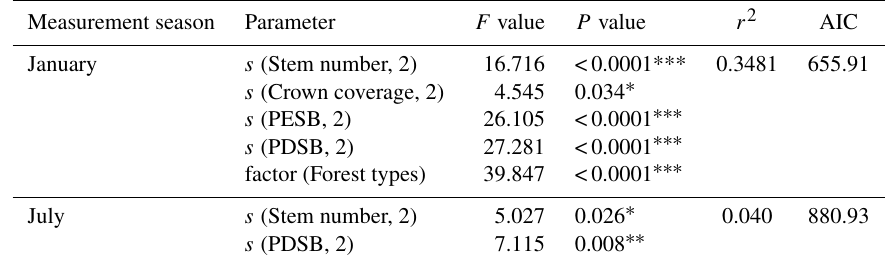
Table 4. Estimated coefficients of the generalised additive models (GAMs) for the factors with effects on LAI values measured in P . massoniana – L . glaber , C . axillaris , and L . glaber – C . glauca